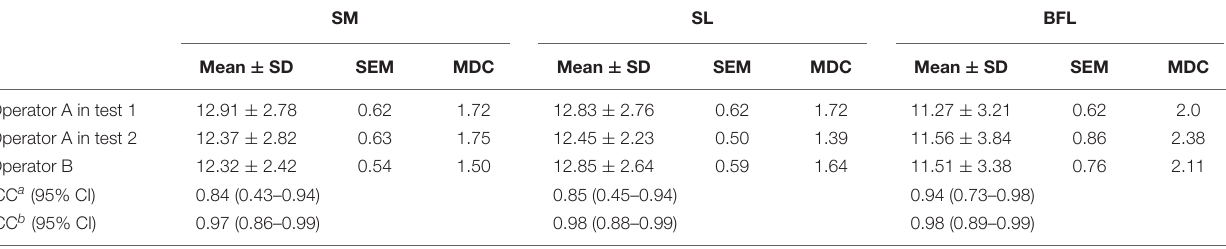
TABLE 2 | Intra- and interoperator reliabilities for assessing the three hamstrings stiffness.